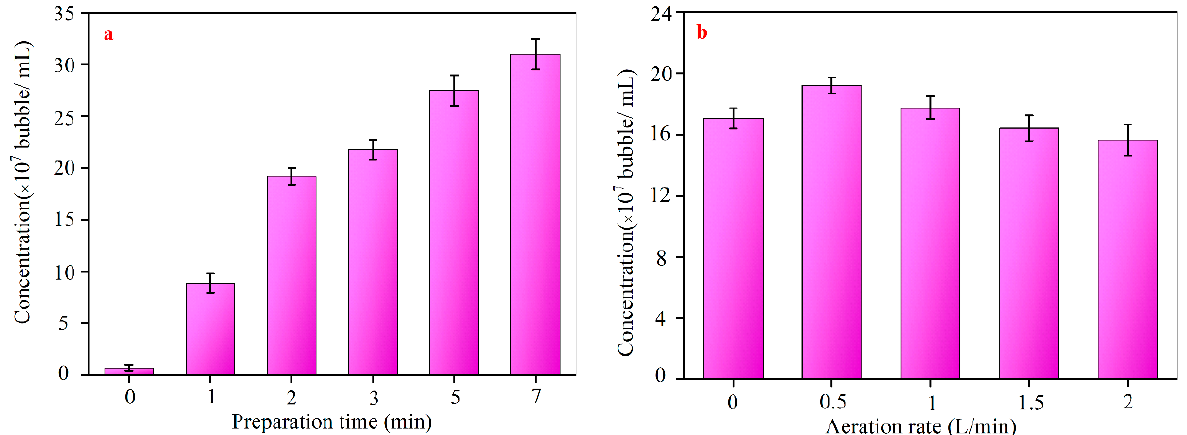
Figure 5. Concentration of bulk nanobubbles prepared as a function of ( a ) preparation time at an aeration rate of 0.5 L/min, and ( b ) aeration rate at preparation time of 2 min.